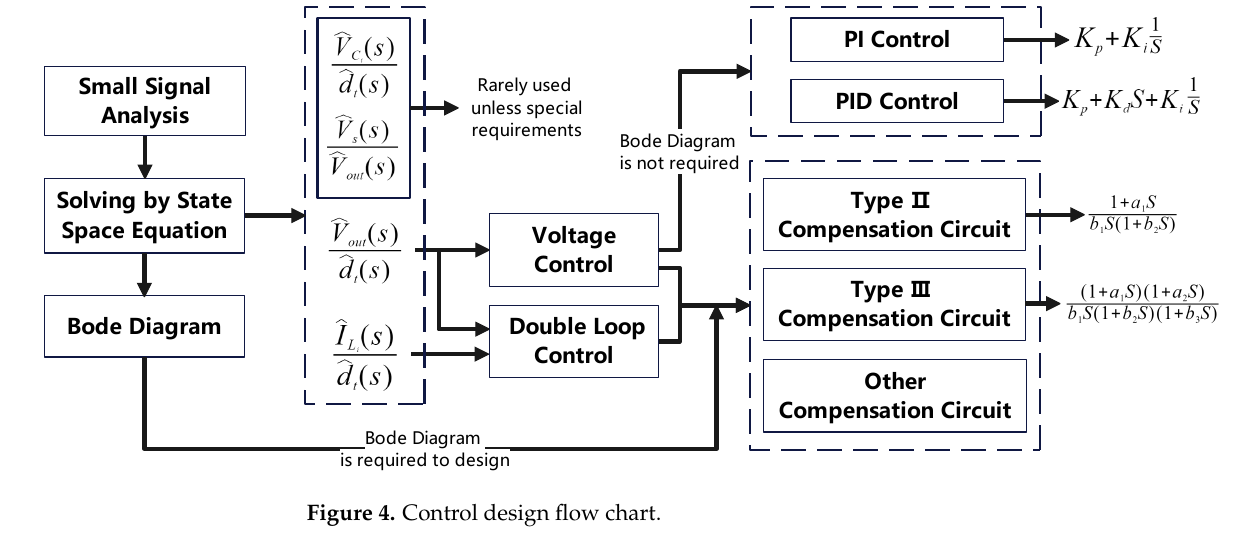
Figure 4. Control design flow